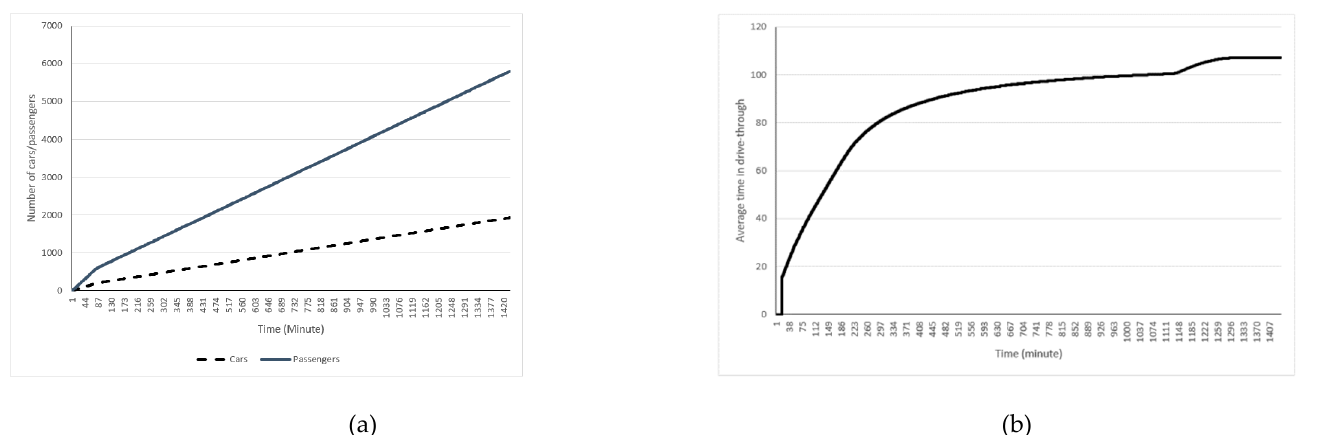
Figure 3. Sample simulation results for number of cars and passengers using the drive-through ( a ) and average time spent in the drive-through ( b ) based on drive-through settings in Table 1.